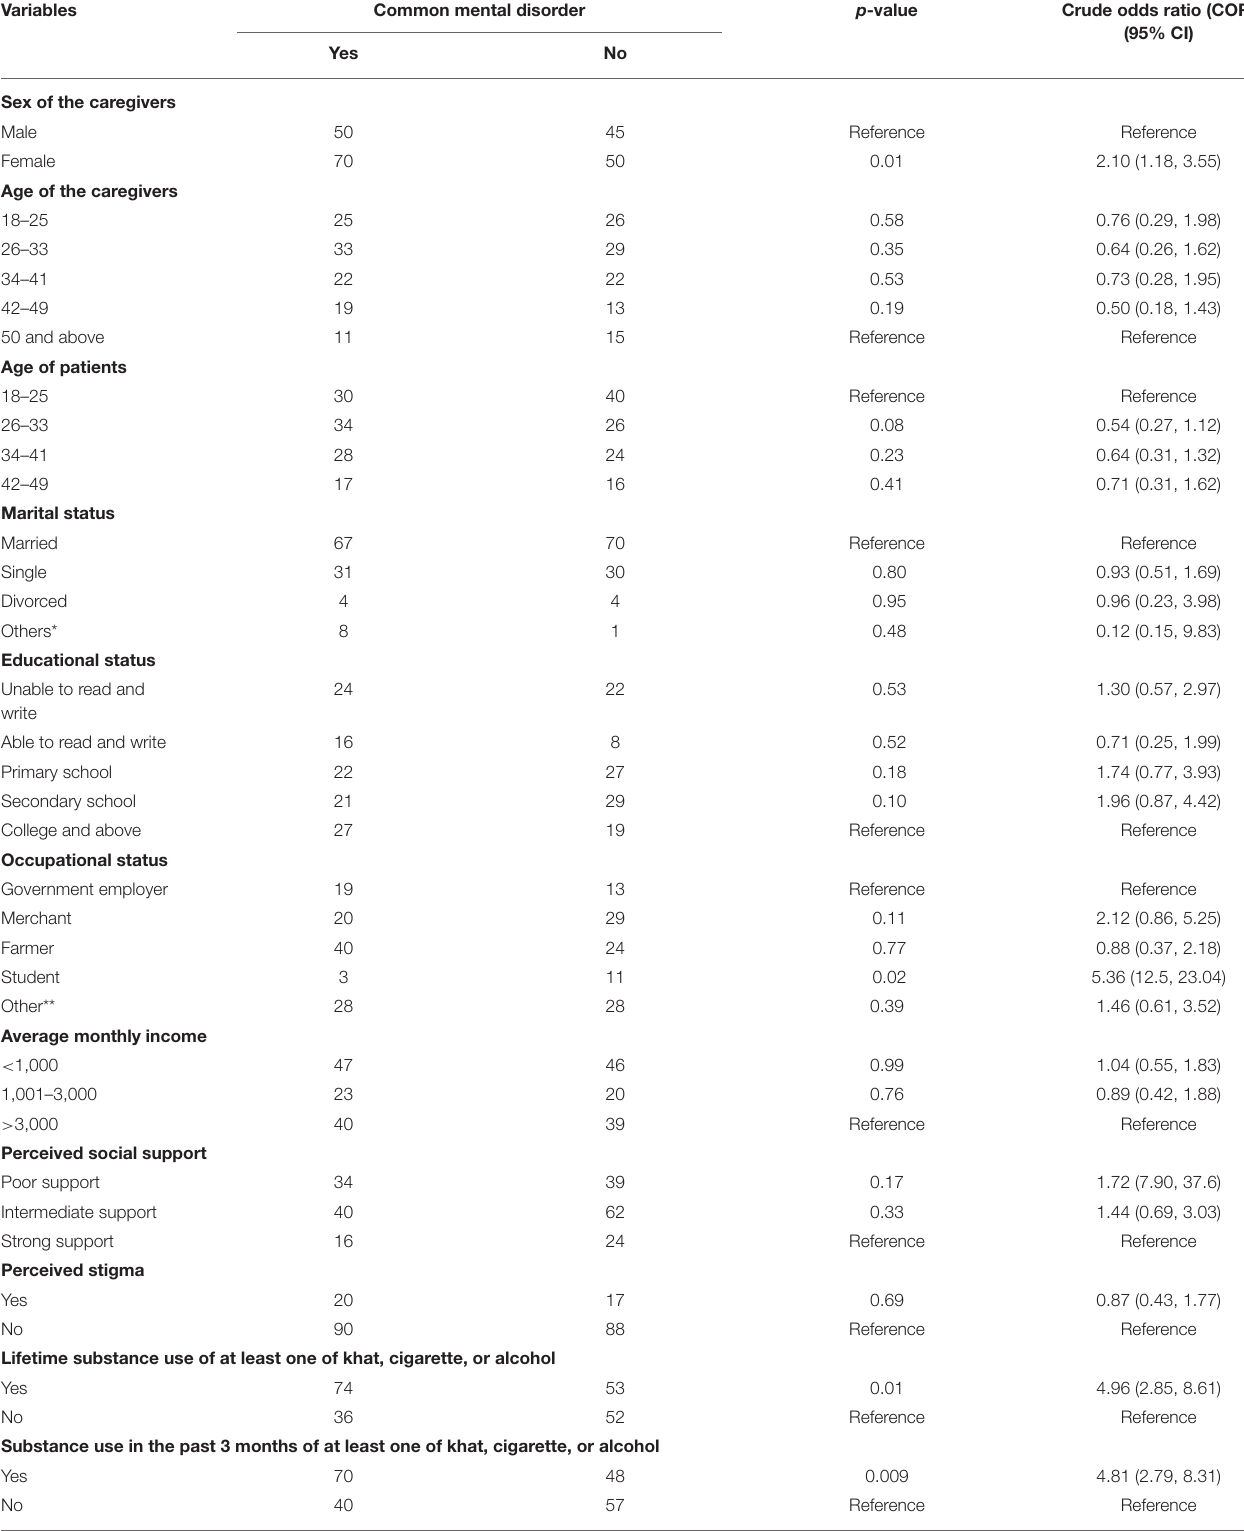
TABLE 3 | Binary logistic regression analysis of factors associated with common mental disorders (CMDs) among primary informal caregivers of adults with mental illness at the HFSUH, Ethiopia,